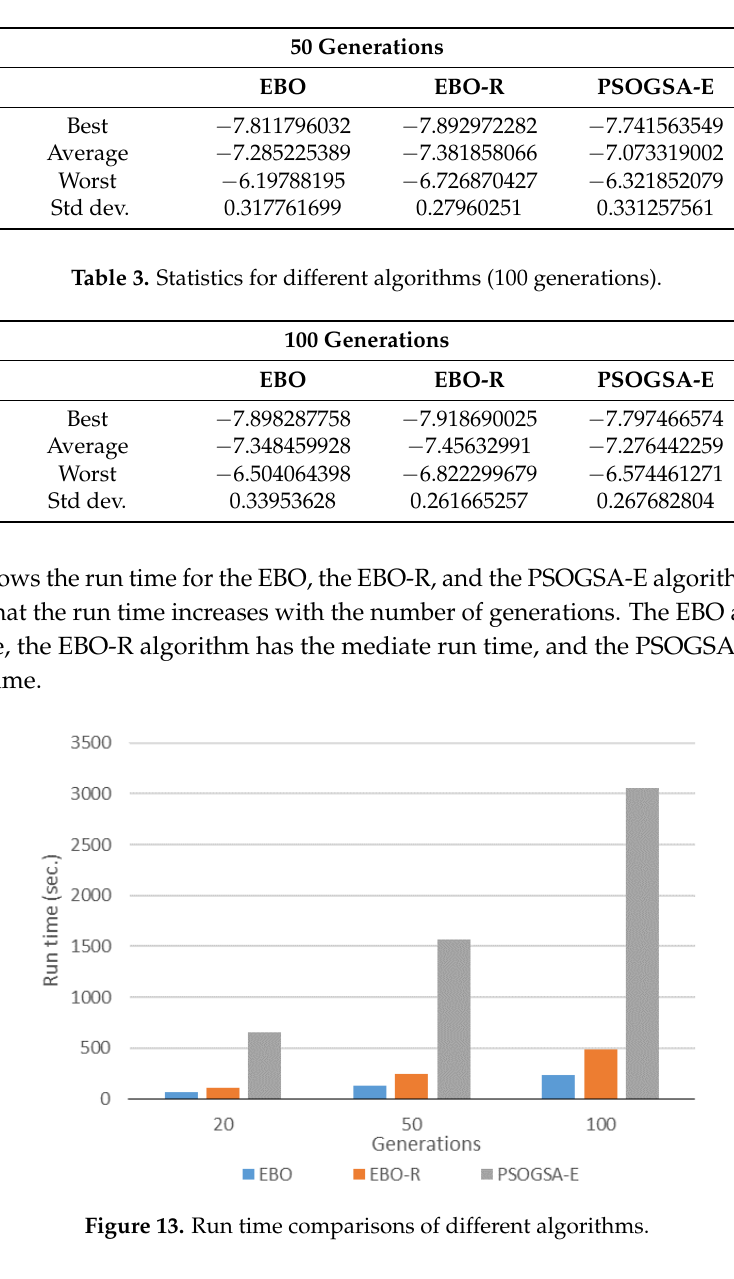
Table 2. Statistics for different algorithm (50 generations).